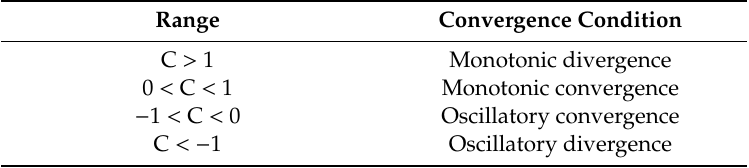
Table 3. Convergence conditions as a function of the C value of the Equation (37)